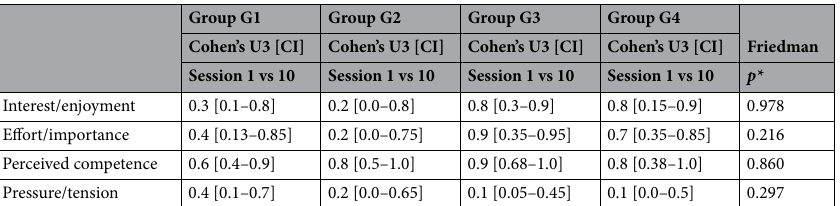
Group G1 Group G2 Group